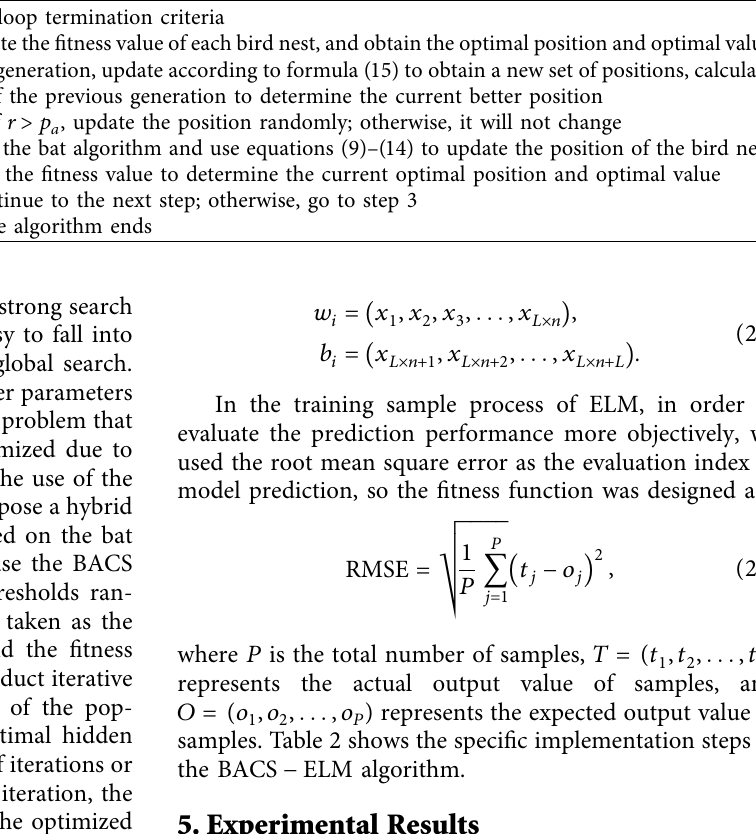
Table 1: Steps of the bat cuckoo hybrid